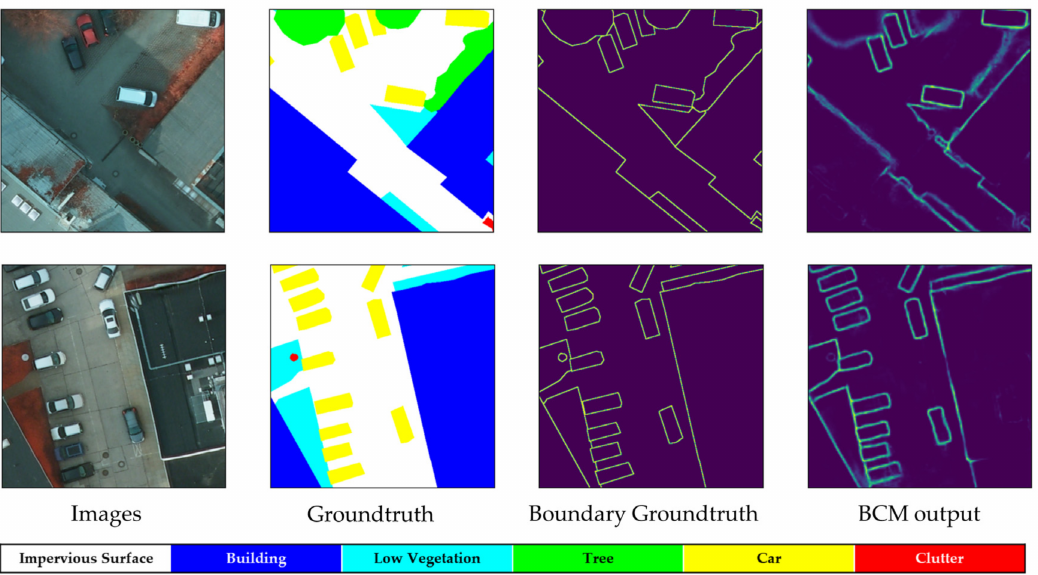
Figure 9. Visualizations of output features from the last BCM. (From left to right ) Columns show the original images, the image ground truth, the boundary ground truth and the output features of the last BCM.